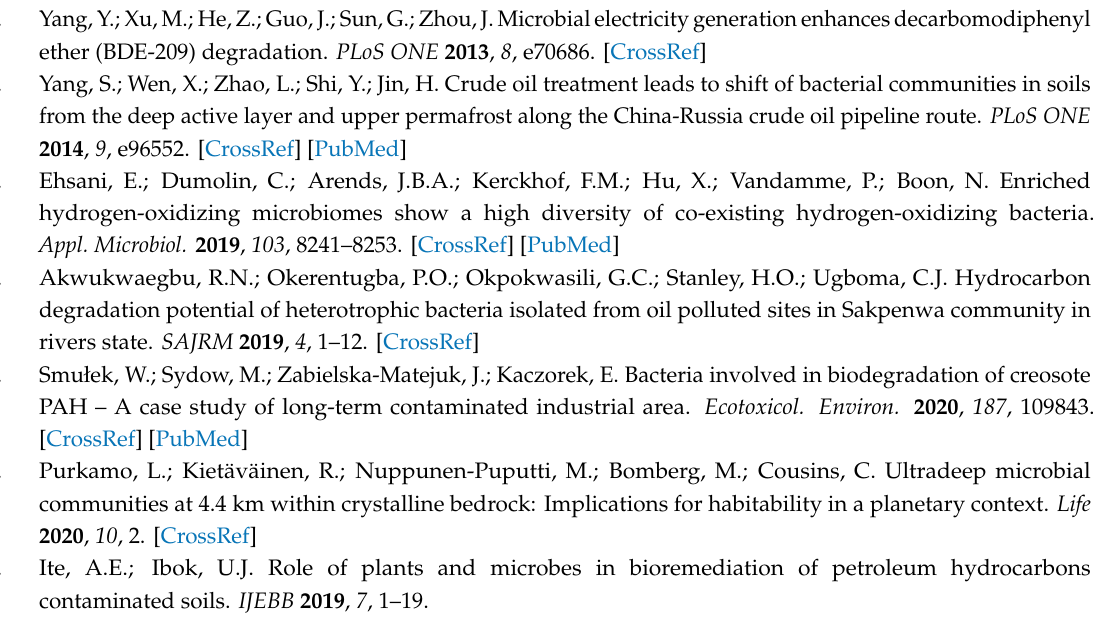
Table S1: Significance tests carried out using the analysis of variance (ANOVA), Table S2: Covariance matrices for intergroup e ff